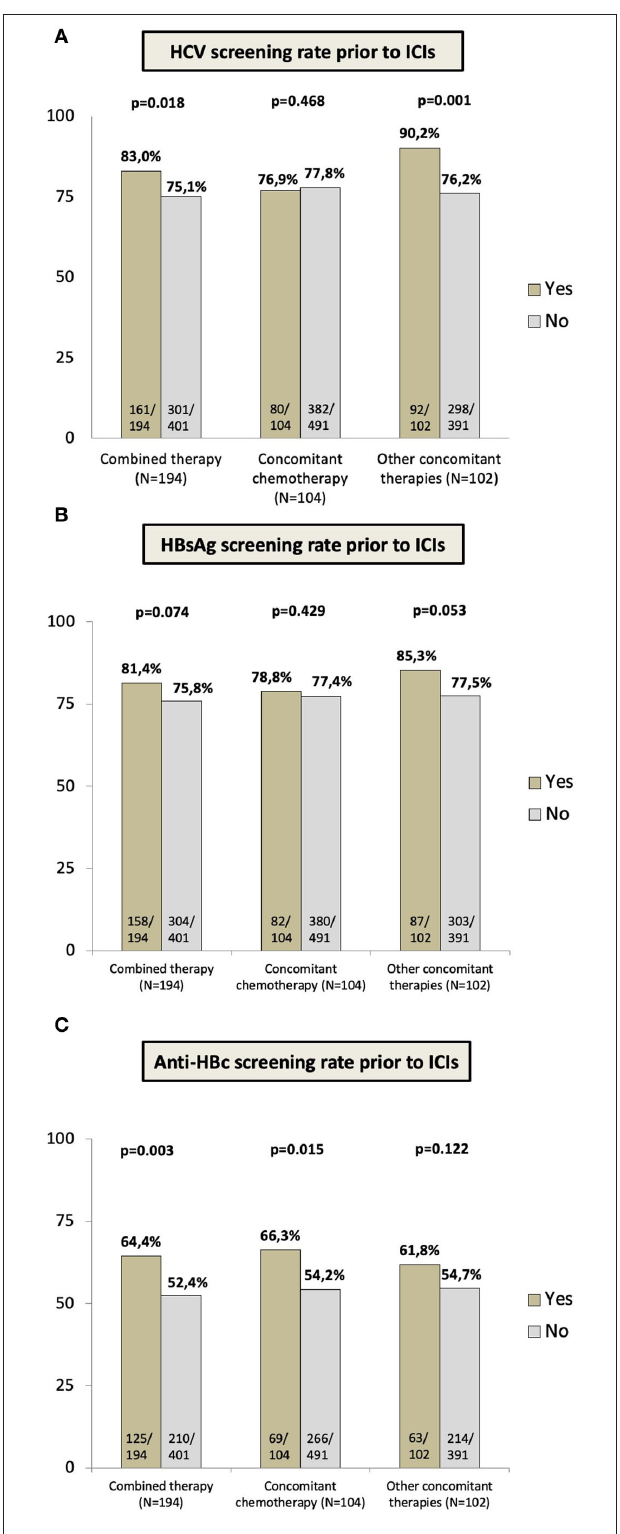
FIGURE 3 | Rate of viral hepatitis testing ordered previous to ICIs starts according to the prescription of concomitant medication (All combined therapy; concomitant chemotherapy; concomitant systemic therapy different